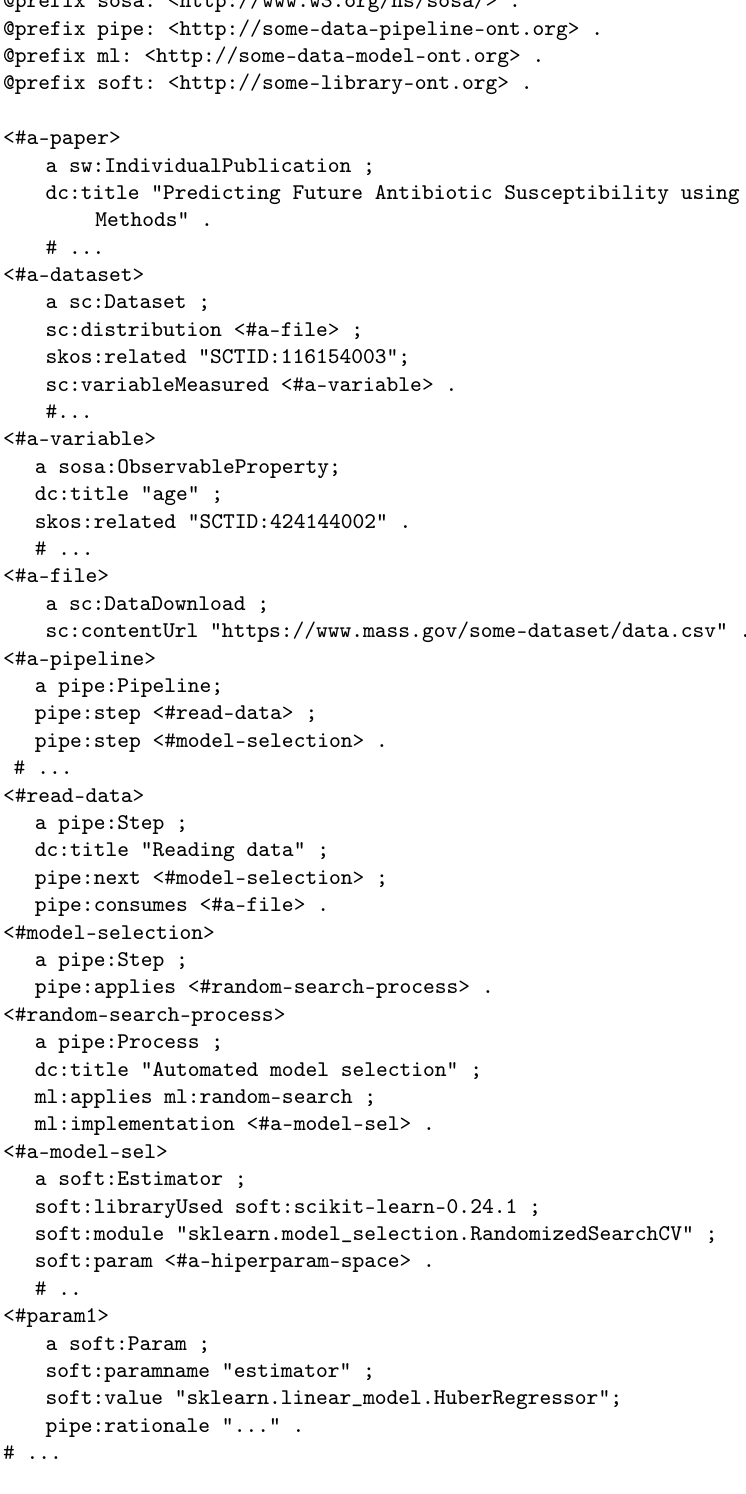
Figure 1. Fragments of RDF annotations of an